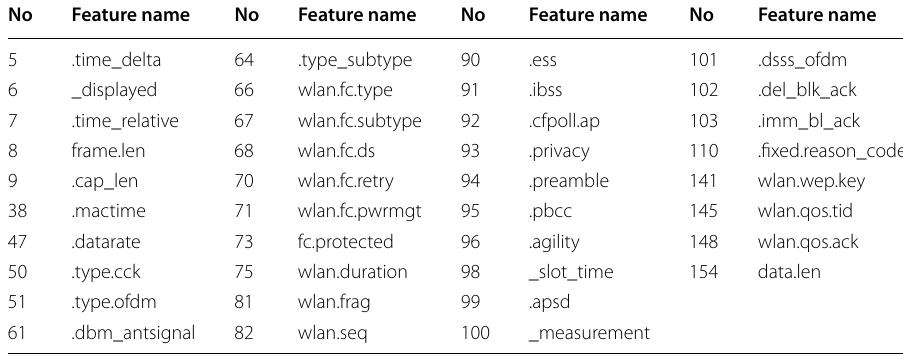
Table 6 Features extracted by extra trees classifier